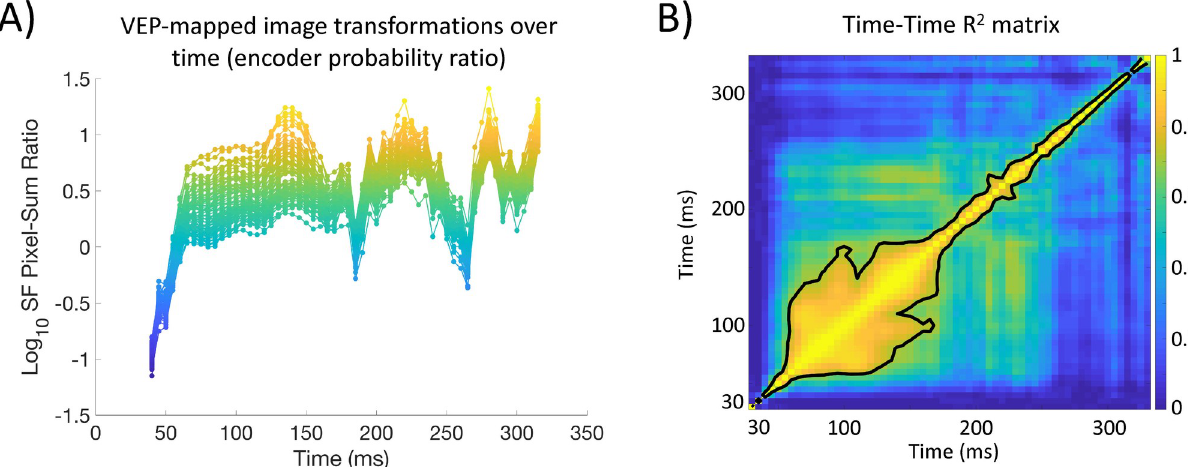
Fig 12. A) Participant averaged log 10 HSF-to-LSF probability ratio for each encoder tagged image over time across the entire stimulus space (i.e., all pixels). B) Participant averaged time-time R 2 matrix assembled by regressing the log 10 HSF-to-LSF probability ratios across images for each time point against every other time point (color bar is R 2 ). The contour line encapsulates the top 12% of the R 2